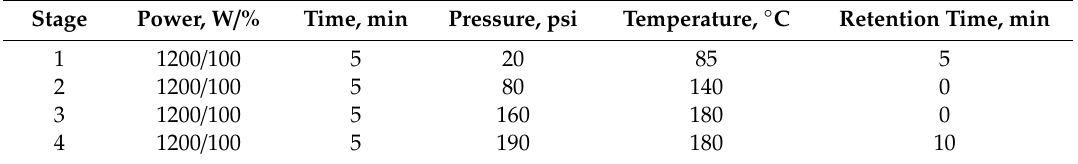
Table 2. Optimized parameters of microwave digestion of biotic samples.